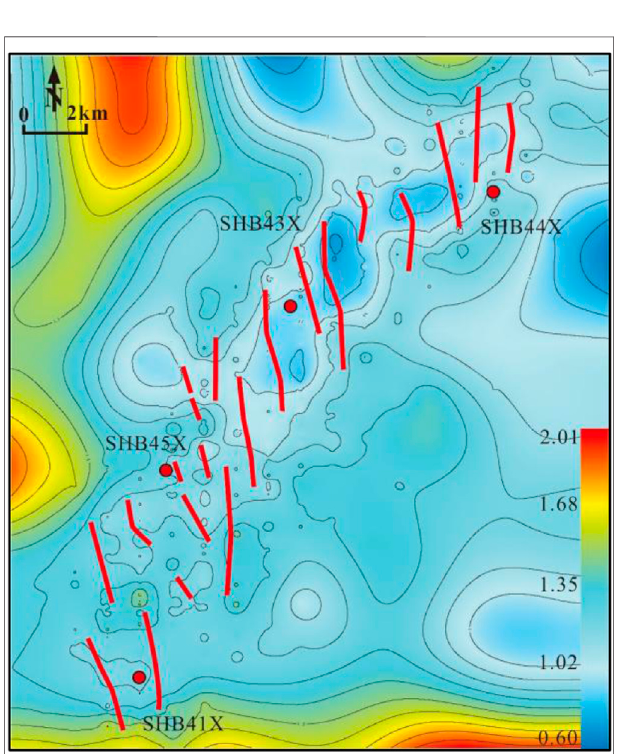
FIGURE 15 | Prediction results of the distribution of Silurian fracture development coef fi cients in the northern segment of the Shunbei No. A fault